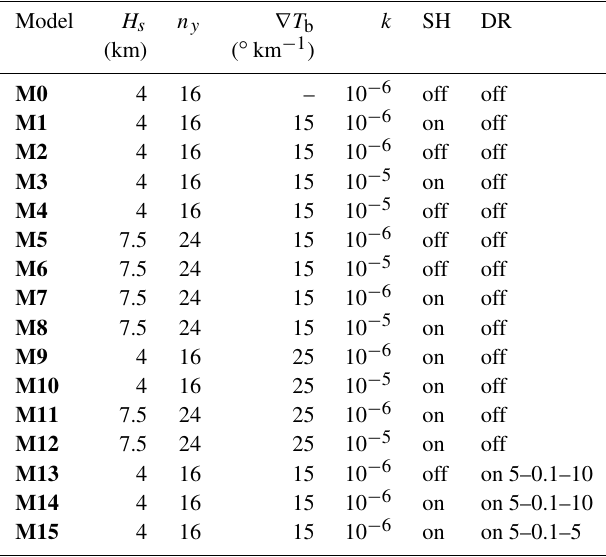
Table 2. Variable parameters. H s indicates domain thickness, n y in- dicates the number of vertical element, ∇ T b indicates the basal ther- mal gradient, k indicates coefficient of diffusion for surface process model, SH indicates shear heating, DR indicates dehydration reac- tion followed by values for temperature-dependent internal friction angle in